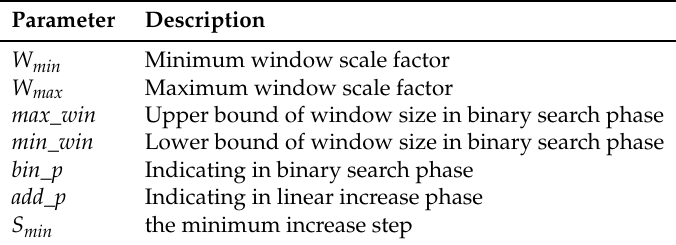
Table 1. Modest BBR congestion control